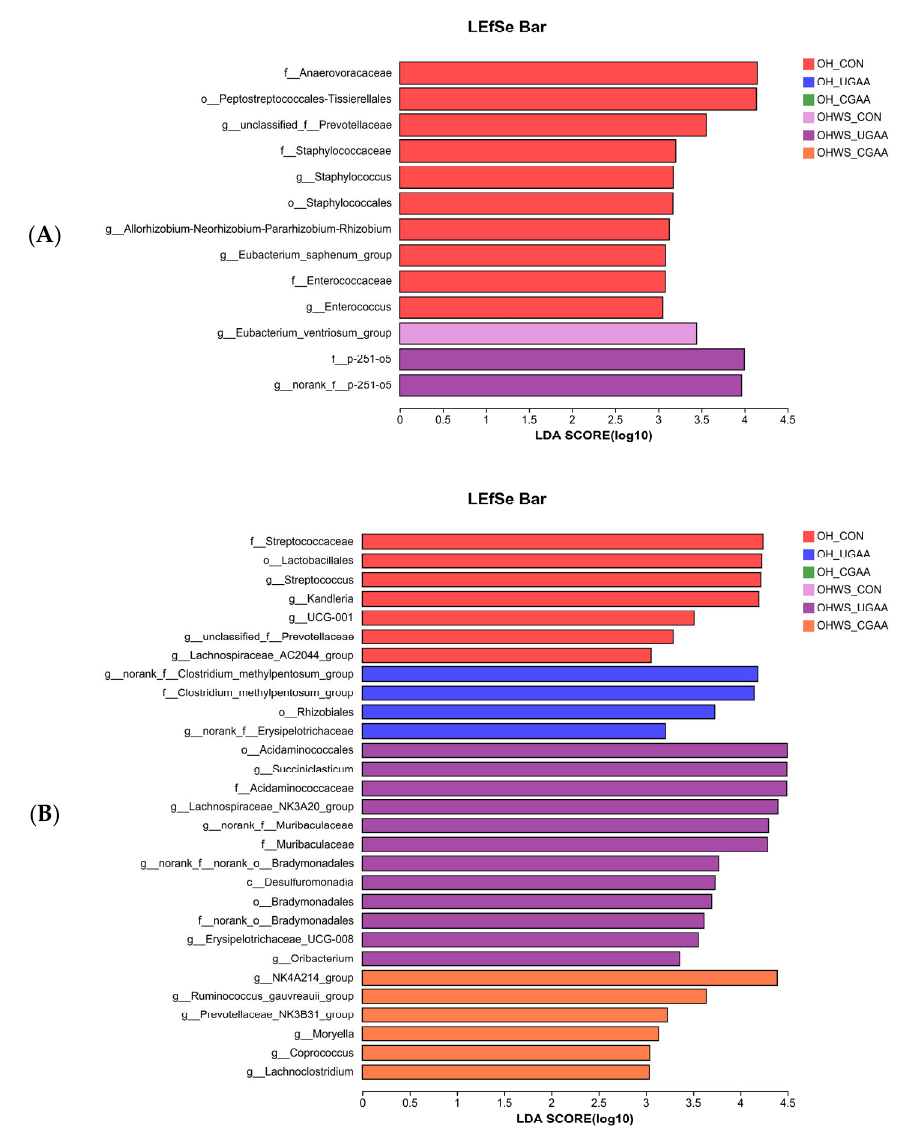
Figure 1. LEfSe bar showing the taxonomic differences in the rumen of lambs in stage 1 ( A ) and stage 2 ( B ). All identified taxonomy was significantly different based on LDA score ( B ) larger than 3.0.